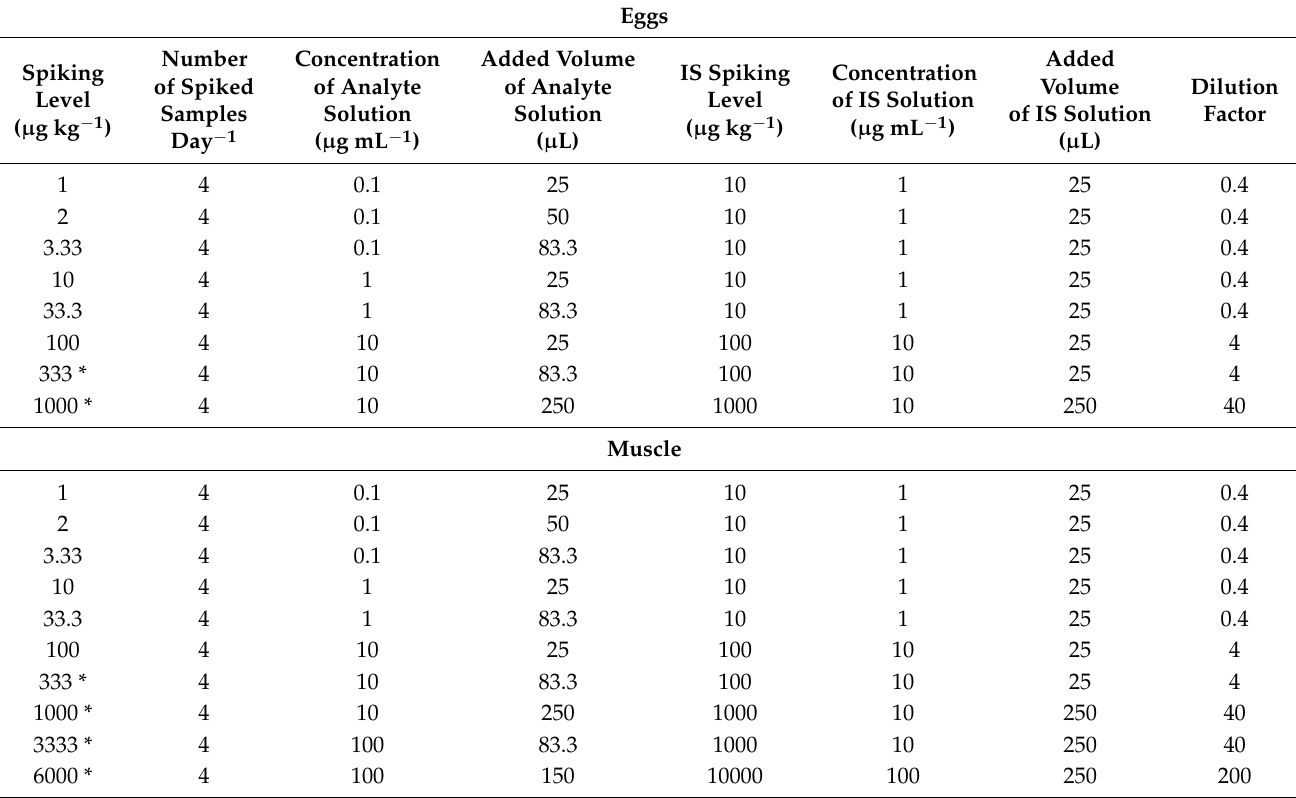
Table 2. Validation